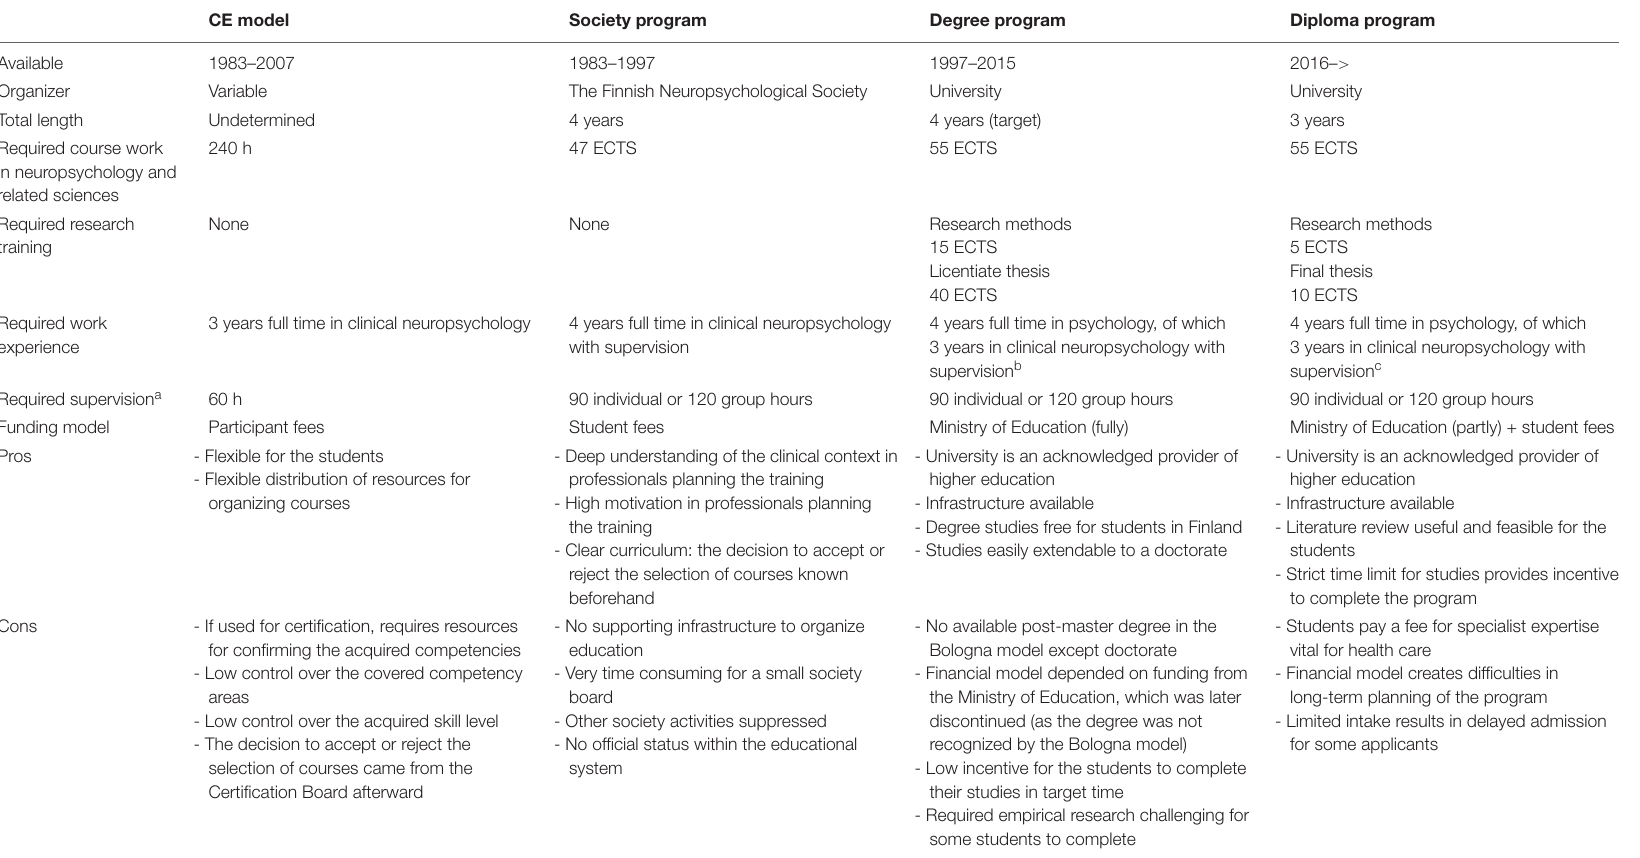
TABLE 1 | Post-master specialization in